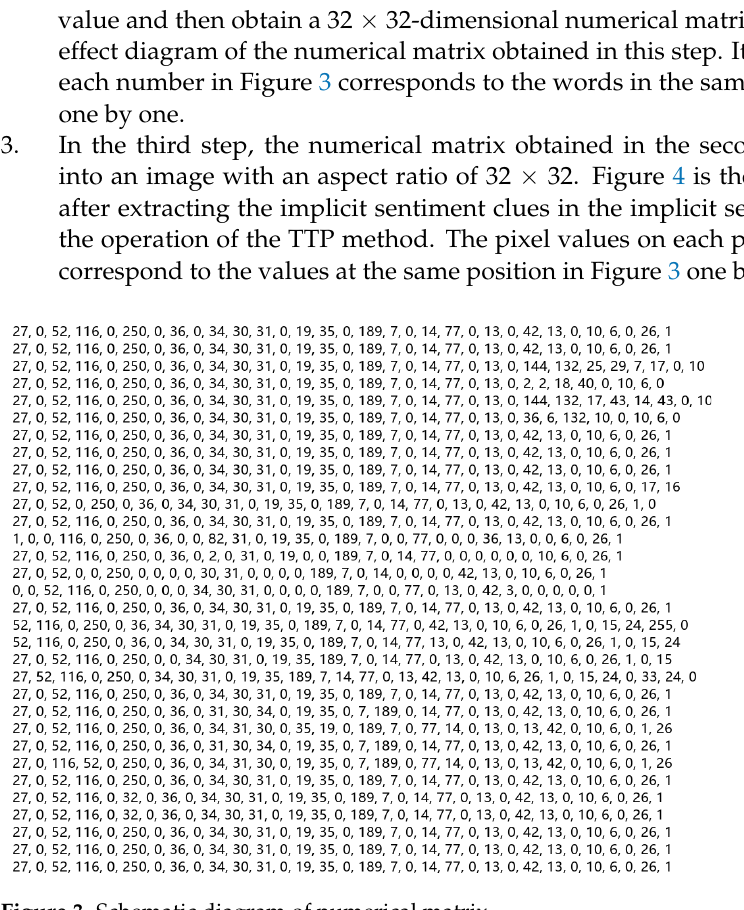
Figure 3. Schematic diagram of numerical matrix.